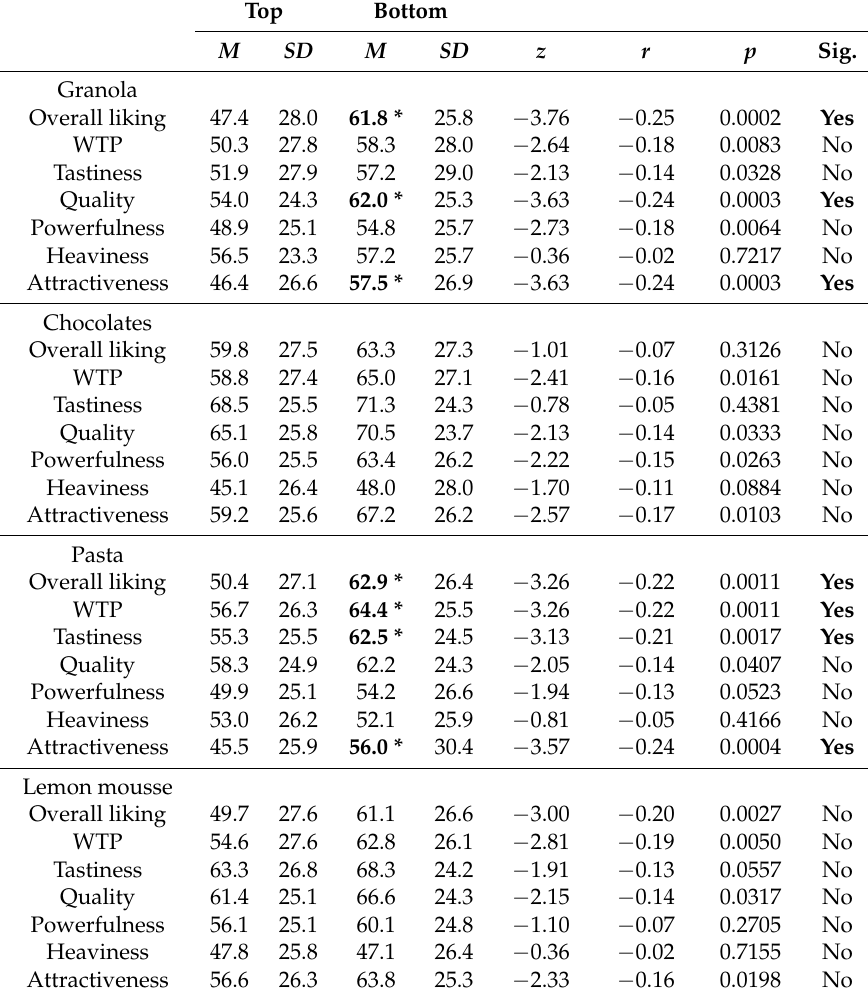
Table 3. Results for the ‘half-window’ (top/bottom) stimuli by